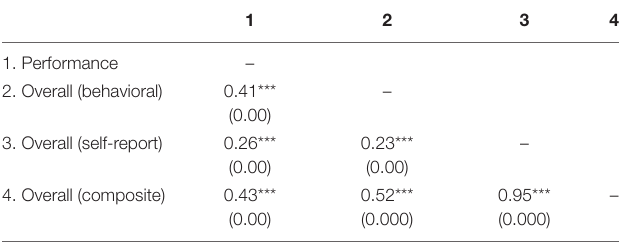
TABLE 2 | Pearson’s correlations between outcome